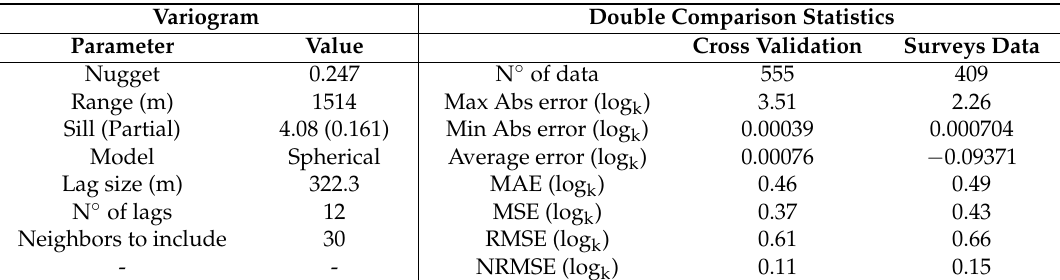
Table 6. Ordinary kriging parameters (left) and cross-validation/comparison with real data (right) for hydraulic conductivity spatial